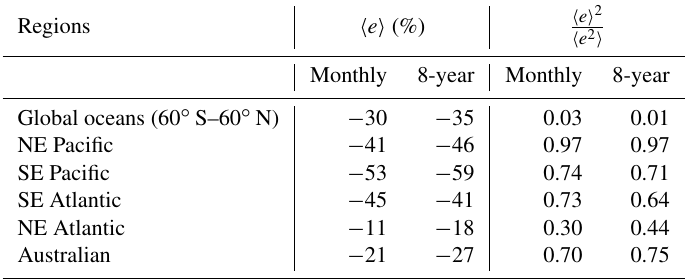
Table 2. As in Table 1 but with the percentage bias, e , calculated as ( (cid:49) SW ∗ is temporally resolved and (cid:49)N d is prescribed to be 300cm − 3 . Note the value of prescribed (cid:49)N d does not affect the results as percentage biases are